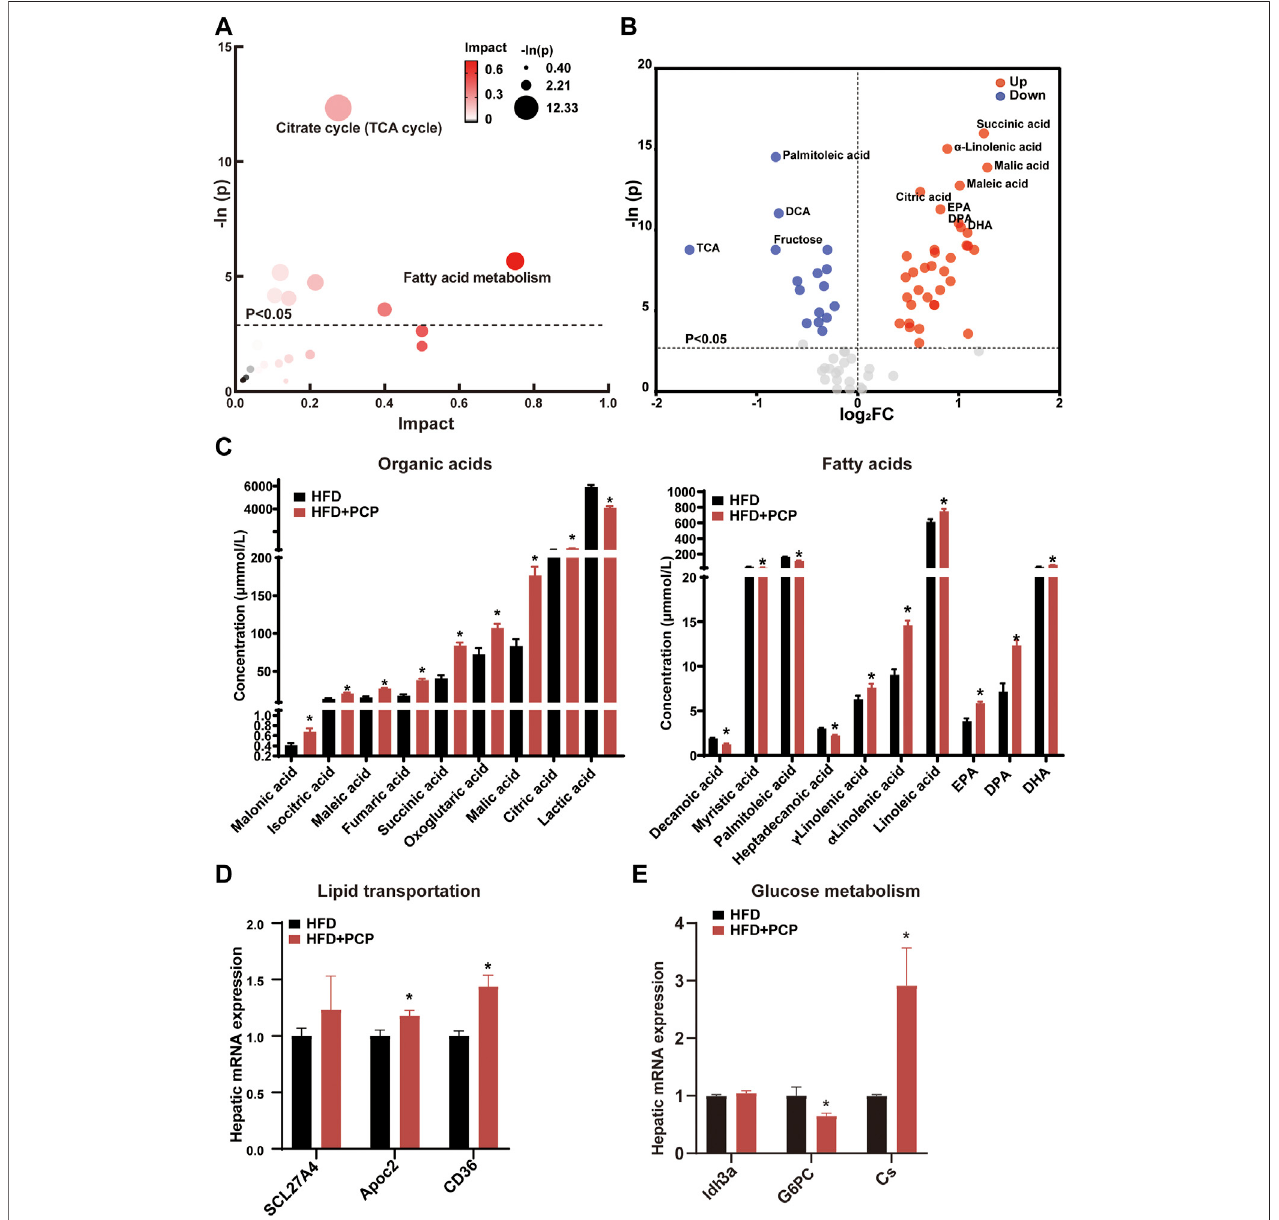
FIGURE4|(A) Bubblechartofpotentialsignalingpathways.PathwayanalysiswasperformedintheKEGGdatabase.Thecolorandsizeofeachbubblerepresent the impact ofmetabolites in each pathway and p value, respectively. (B) Volcano plot forthe differential metabolites (HFD+ PCP group vs. HFD group). Metabolites with statistically signi fi cant differential levels lie above a horizontal threshold line. Metabolites with large fold change values lie far from the vertical threshold line at log2-fold change=0,indicatingwhetherthemetaboliteisupordownregulated. (C) Theconcentrationofdifferentialserummetabolites. (D) ThemRNAexpressionofhepatic lipid transportation-related genes. (E) The mRNA expression of TCA cycle-related genes. n = 8 individuals/group. Data were expressed as mean ± SEM. Differences between data were assessed by the Mann – Whitney U test; * p < 0.05 compared with the HFD group.